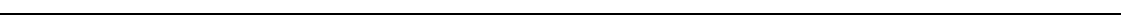
Fig. 5 miR-29 targets key components of the Wnt signaling pathway. a Design of the study. b Volcano-plot of fold changes of individual proteins from NRCM transfected with antimiR-29 or antimiR-ctrl. Dark gray symbols highlight signi fi cantly deregulated proteins ( P < 0.05) and orange symbols those with known or predicted pro fi brotic function. LUM Lumican, CTSL Cathepsin L, LGALS3BP Galectin 3 Binding Protein, CST3 Cystatin C, CDH2 Cadherin 2, ECM1 Extracellular Matrix Protein 1, APP Amyloid Beta Precursor Protein. c Signi fi cant GO enrichment of transcription factor binding sites in the deregulated secreted factors. d (Left) Wnt activity using a TCF/LEF reporter assay in NRCM 48 h after transfection with miR-29a or miR-ctrl. (Right) NFAT activity in NRCM 48 h after transfection with miR-29a miR-ctrl; 4 – 5 independent experiments in triplicate. e miR-29 directly regulates the Gsk3 β , Ctnnbip1 , Hbp1 and Glis2 3 ´ -UTRs. HEK293 cells were transfected with miR-29a or miR-ctrl. Ratiometric analysis of fl uorescent emissions from a dual fl uorescent reporter carrying the Gsk3 β , Ctnnbip1 , Hbp1 and Glis2 3 ´ -UTRs or seed mutants. Data are from 8 independent experiments performed in triplicate. f The transfected with either miR-29 or miR-ctrl in the presence or absence of IWR-1 scale bar: 100 μ m. NRCM were identi fi ed based on α -actinin detection (green) and are assigned green nuclei, whereas non-myocytes were assigned red nuclei. (Down) Quantitative analysis of the results. Data are from four independent experiments performed in triplicate. g Proposed mechanism how miR-29 promotes Wnt signaling in CM and signals to fi broblasts. In cardiac myocytes, miR-29 (by targeting Gsk3b Ctnnbip1 , Hbp1 and Glis2 ) activates the Wnt signaling pathway, as well as NFAT activity. Activation of Wnt and